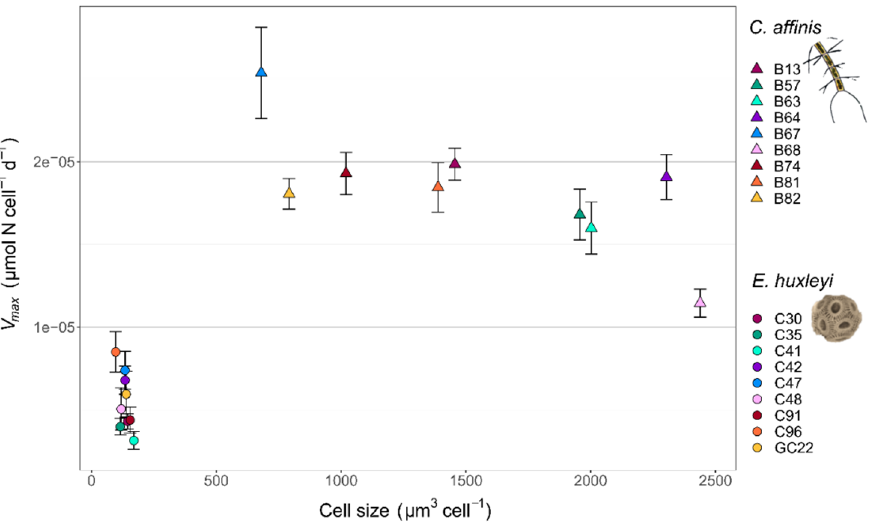
Figure 2. V max and cell size of the nine genotypes for E. huxleyi and C. affinis respectively. Error bars of V max show SE of Monod model estimates.